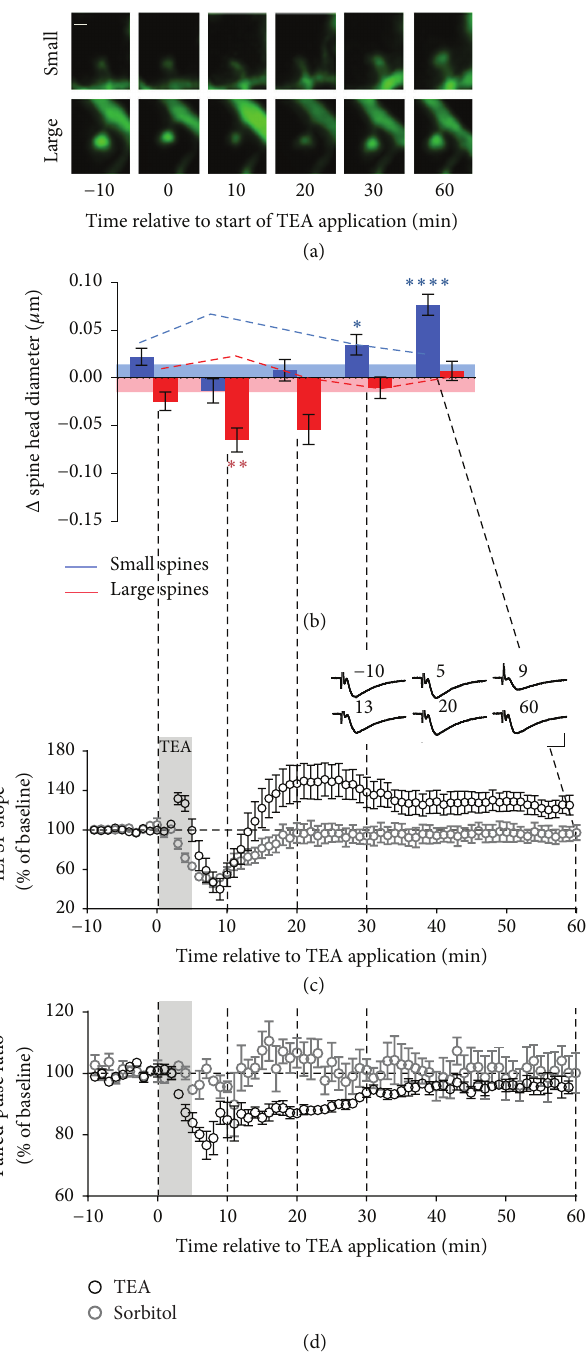
Figure 2: Large and small dendritic spines in CA1 pyramidal cells respond to TEA with different time courses corresponding to different phases of the synaptic response. (a) Typical example of a small and a large spine imaged before ( − 10), during (0), and after washout (10– 60 min) of TEA (25 mM, 5min). Scale bar: 0.5 𝜇 m. (b) Quantification of changes in spine size relative to the pre-TEA measurement. Small spines, blue; large spines, red. Limits of the shading represent the mean change across time in the absence of TEA (time course control experiments). The dotted lines represent the mean change at each time point in response to sorbitol (osmolarity control experiments). Post hoc analysis of control data versus TEA (3-way interaction between size, time, and treatment): ∗ 𝑝 < 0.05 ; ∗∗ 𝑝 < 0.01 ; ∗∗∗∗ 𝑝 < 0.0001 . (c) fEPSP slope and (d) PPR recorded in the CA1 region of acute hippocampal slices in response to stimulation of the Schaffer collateral before, during, and after application of TEA (black symbols) or sorbitol (grey symbols) as above. Error bars: SEM. Grey shading: TEA perfusion. Inset: averages of fEPSPs recorded from a typical slice over 1min at 10s intervals at the time indicated (min). Scale bar: 1mV,